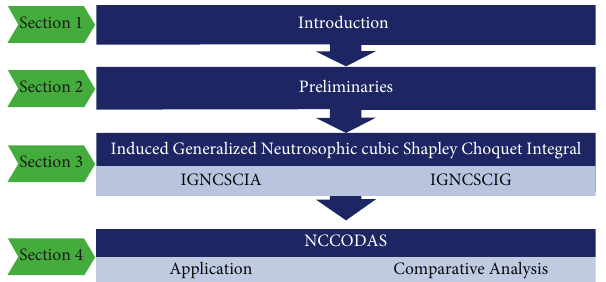
Figure 1: Research organization